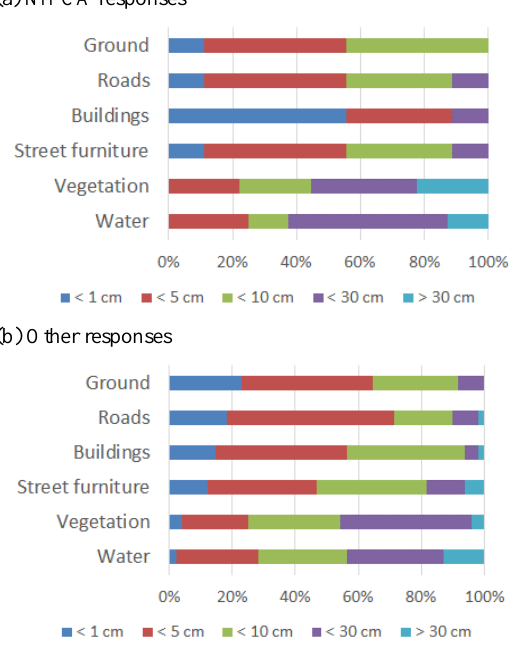
Figure 5. Requisite accuracy for various infrastructure: (a) NMCA responses; (b) all other